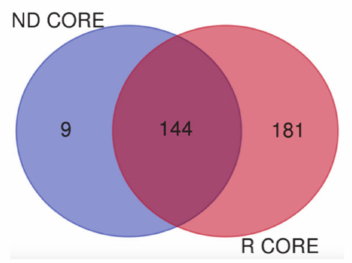
Figure 12. Venn diagram between the 153 ND Core proteins and 325 R Core proteins.